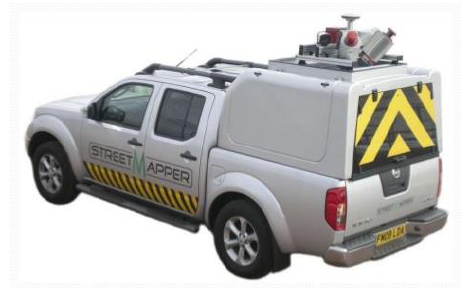
Figure 1. Street Mapper, the LiDAR mobile mapping system utilized in this